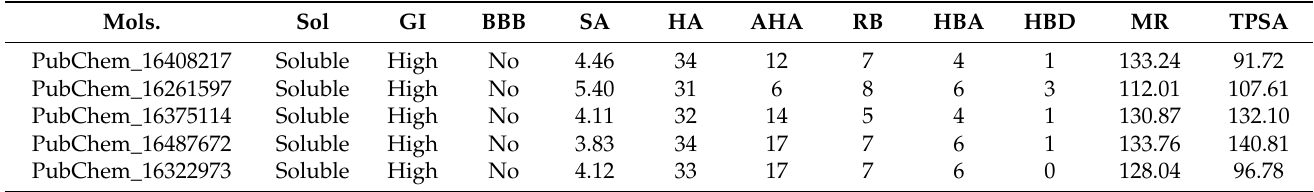
Table 2. Pharmacokinetic and drug similarity parameters of proposed CYP3A5 molecules. Mols.